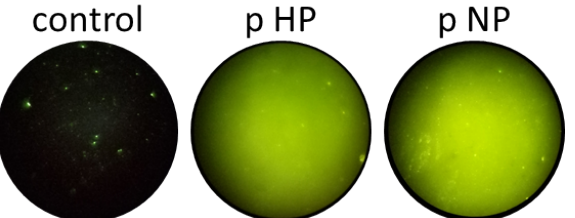
Figure A3. Representative fluorescence microscopic images of adsorbed FITC-PHMB at the untreated surface (control), and after oxidation p-Ti6Al4V discs with H 2 O 2 (HP) or after NaOH treatment (NP). Although the amino end-group was blocked with FITC, PHMB adsorbed onto the treated